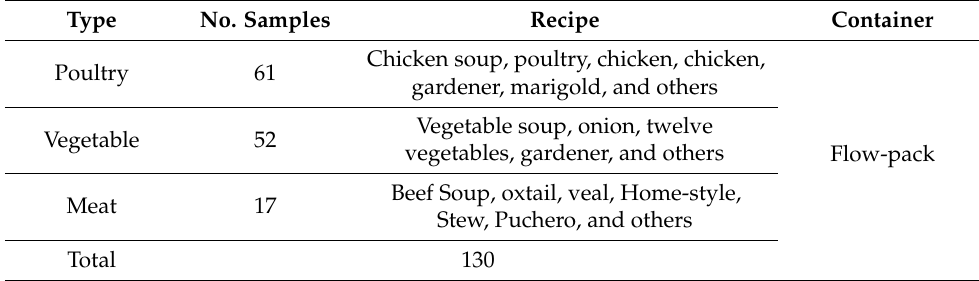
Table 1. Characteristics of the analysed samples.